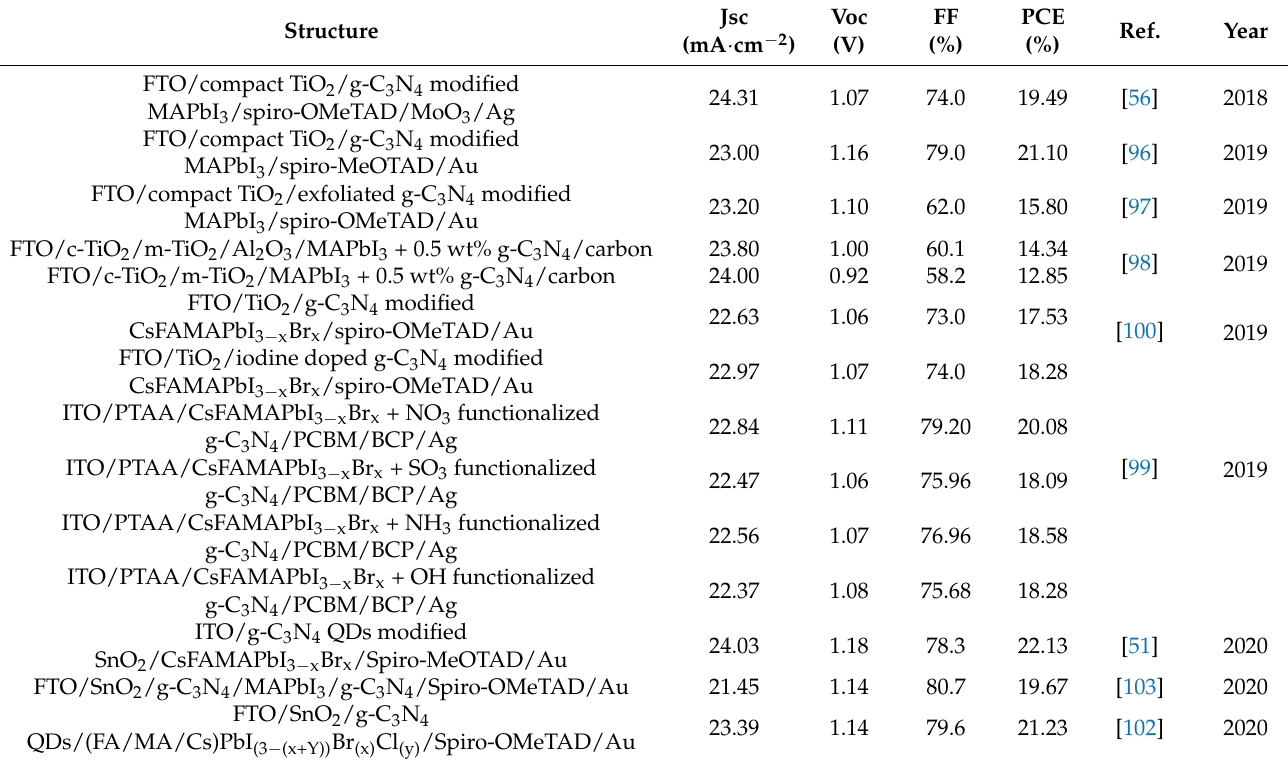
Table 1. Recent development of g-C3N4 based PSC photovoltaic performance.